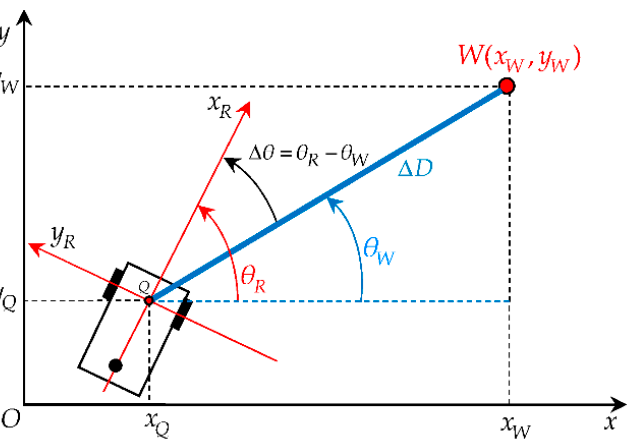
Figure 4. The differential drive wheeled mobile robot and the waypoint parameters.